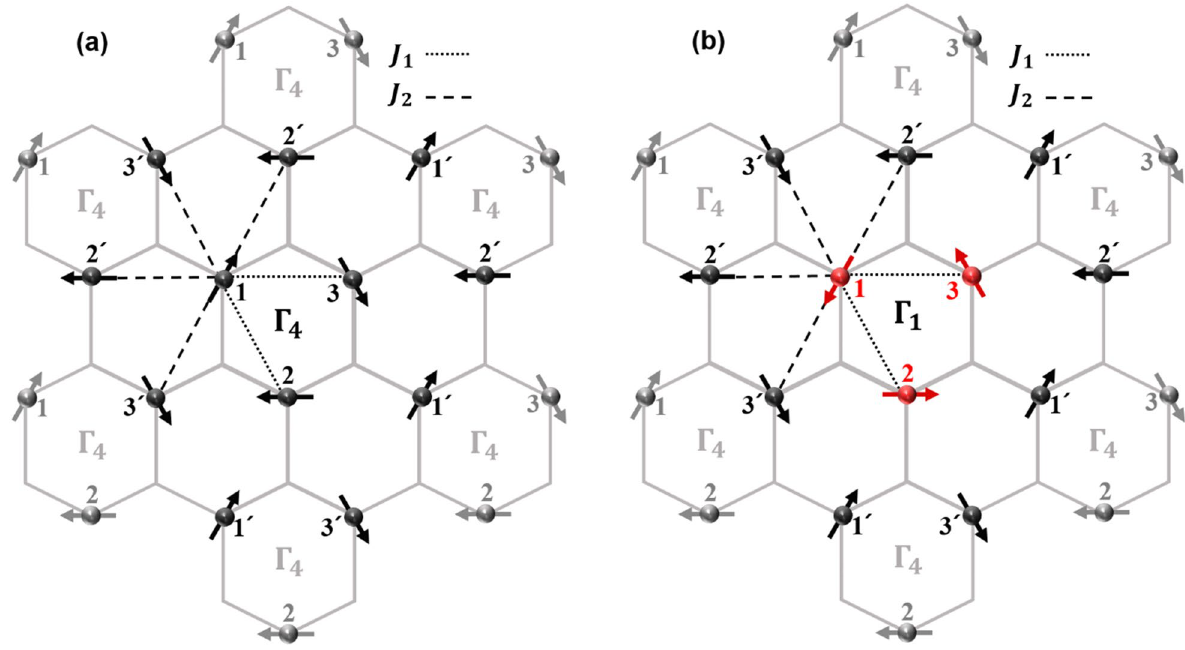
Figure 3. A trimer composed of three Mn-ions (center), and its six neighbors in the z = 0 plane in hexagonal LuMnO 3 single crystal. Below T N , each trimer has two kinds of spin exchange integral: Dotted lines (nearest neighbor) indicate spin exchange integral J 1 , and dashed lines (next nearest neighbor) indicate spin exchange integral J 2 . ( a ) Every trimer has Ŵ 4 spin structure in the ground state. ( b ) Norm trimer has the Ŵ 1 spin structure locally after the spin-flip excitation, while its six neighbors remain in the Ŵ 4 spin structure.